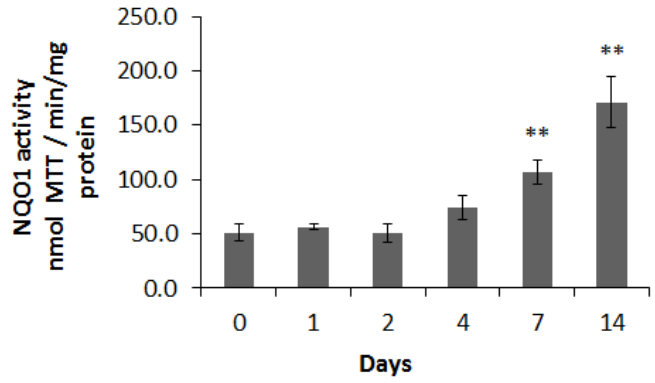
Figure 3. Activity of NQO1 in rat colonic mucosal tissue following cooked broccoli feeding (0–14 days; n = 6). Results are nmol MTT/min/mg protein. Data are mean ± SE. ** indicates significantly different from control (Day 0) ( p < 0.01).